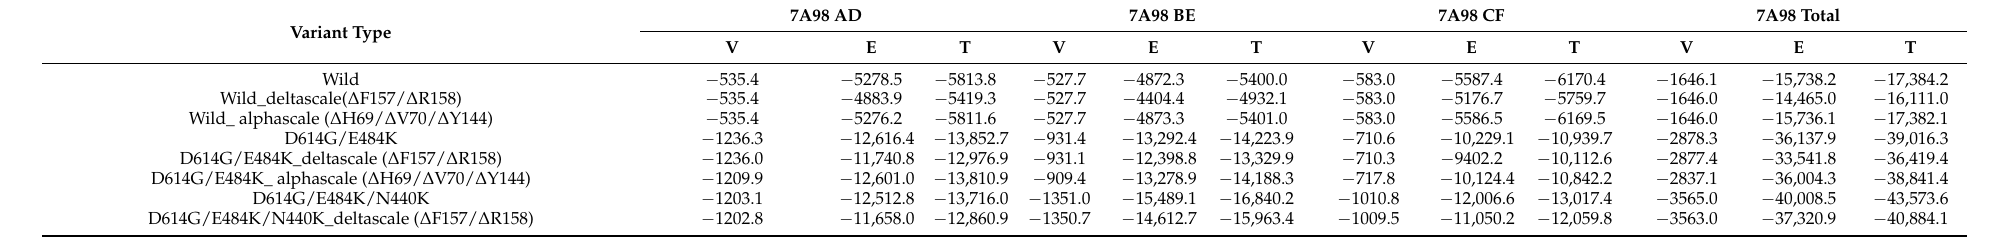
Table 4. Summary of the MM/PBSA between the S protein and ACE2 in the three-open-complex form. V indicates van der Waals energy, E denotes electrostatic energy, and T is the total energy (kJ/mol). The values were measured in the final trajectory (10 ns). Variant